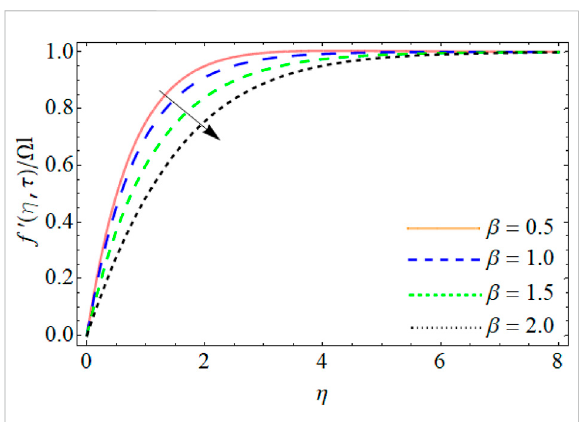
FIGURE 2 Velocity outlines f ′ ( η , τ ) versus Casson fl uid factor β .